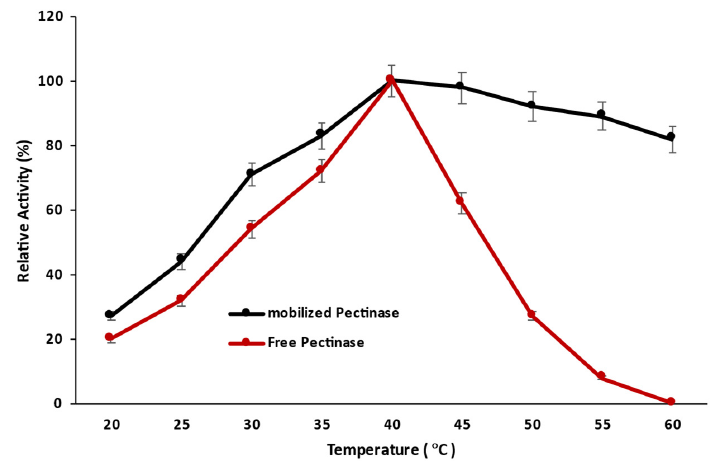
Figure 7. Effect of temperature on the catalytic activity of pectinase immobilized magnetic iron oxide nanocarrier.